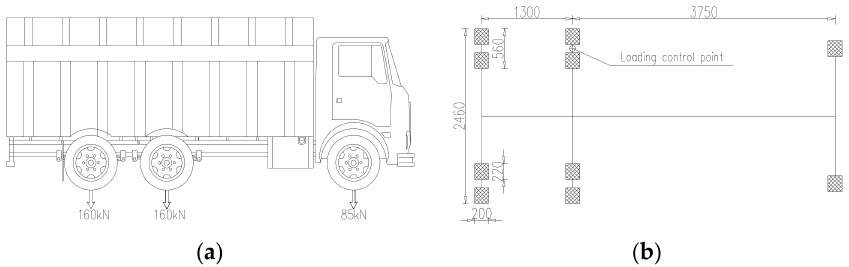
Figure 8. Test vehicle information: ( a ) Load distribution of the test truck; ( b ) Dimension of the wheel / ground contact face. (unit: mm).